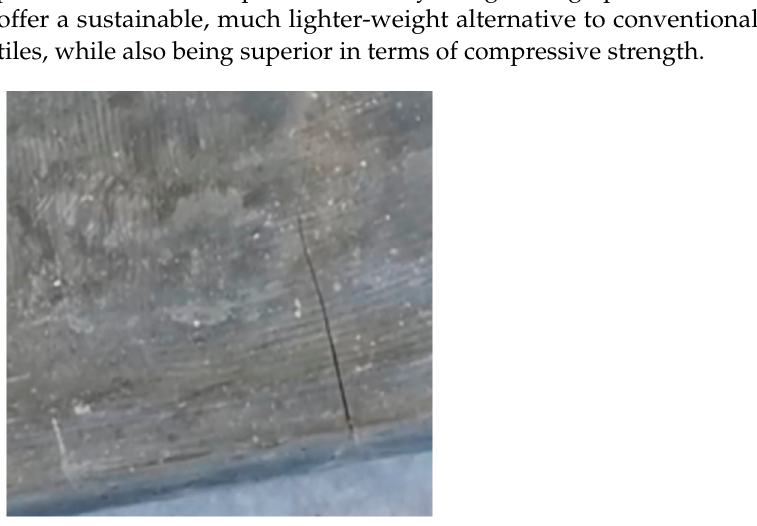
Figure 9. 70%DM ‐ 30%GGBS Pavement tile specimen image. Figure 9. 70%DM-30%GGBS Pavement tile specimen image. Table 6. Average density of Paving Flag Specimens per